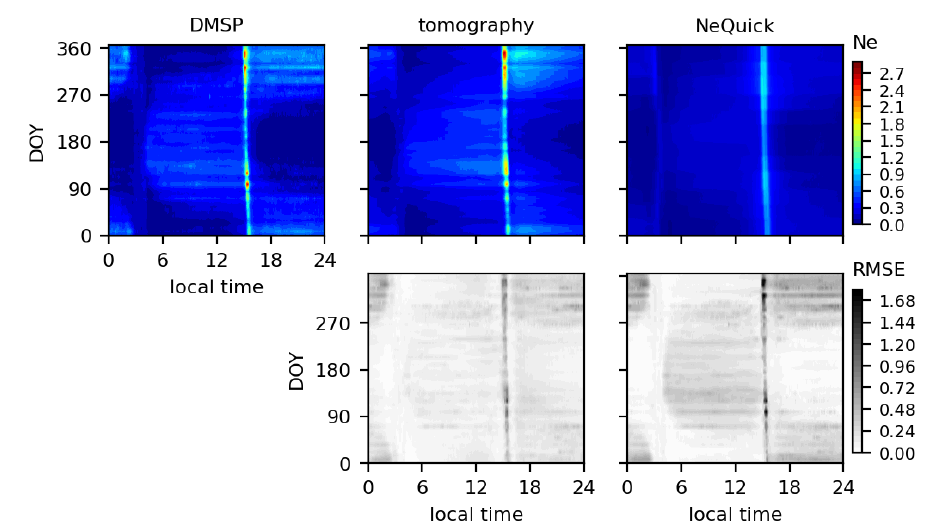
Figure 9. Electron density and RMSE distributions during 2013 obtained with DMSP number 15, NeQuick and tomography. The electron density Ne (el/m 3 ) was estimated based on a daily average in terms of local time.